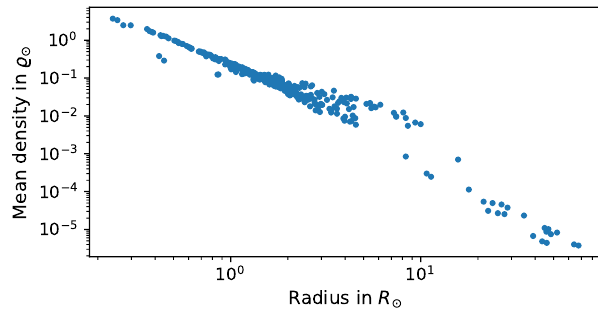
Fig. 29.— Plotting radius against density, both in solar units. Data from DEBCat which are the main sequence stars and which are the red giants. With the red-blue distinction, the situation becomes clear, as shown in Fig. 30. Red giants are not